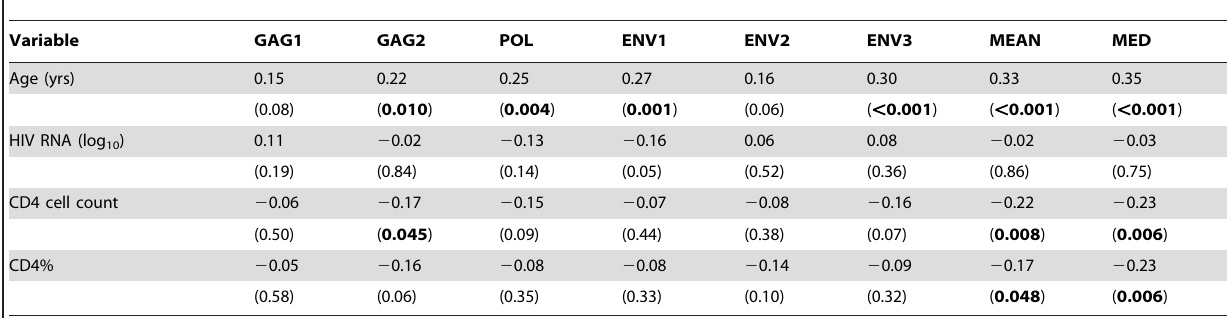
Table 2. Correlation of HIV diversity and continuous demographic and clinical factors.